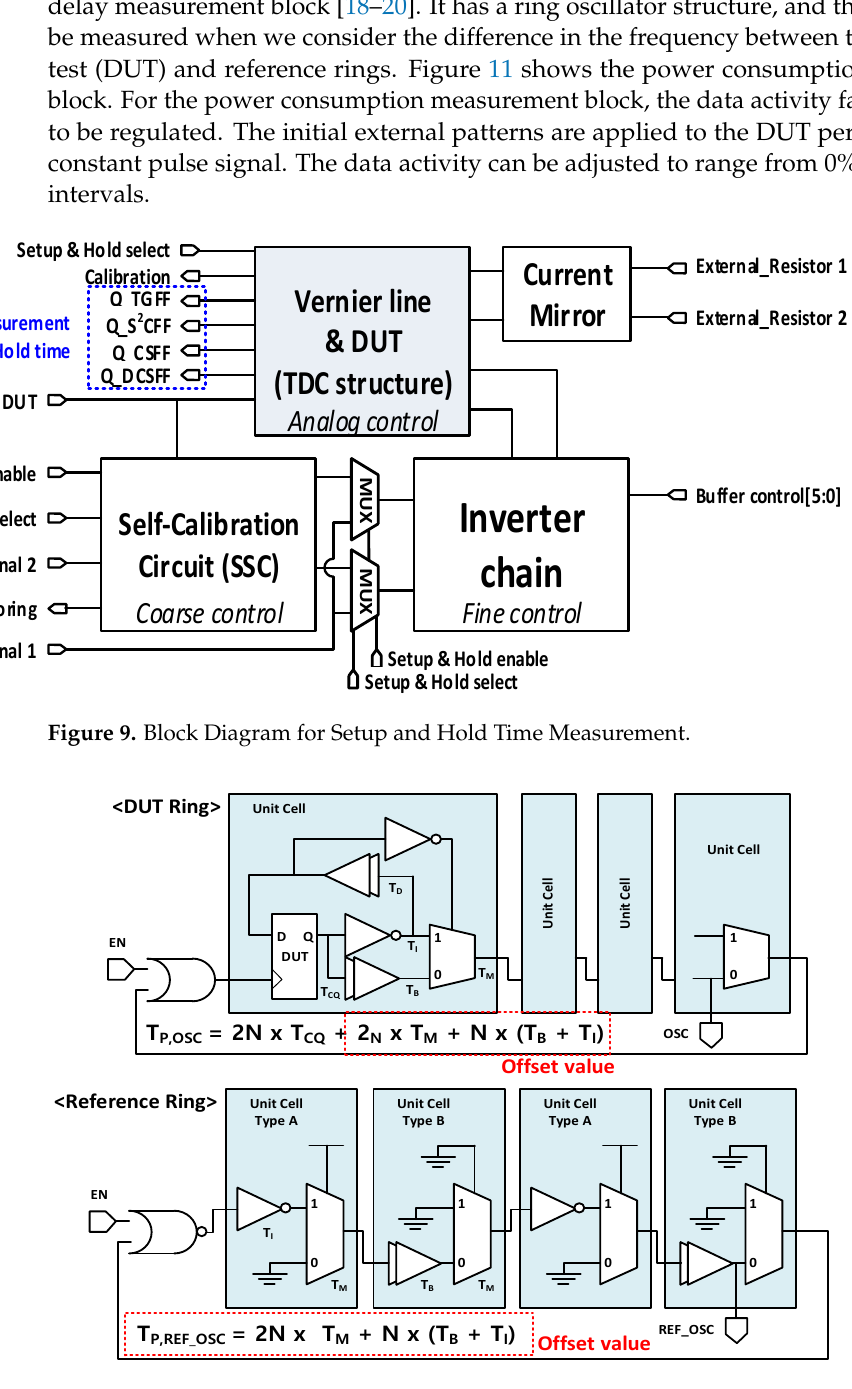
Figure 10. Block Diagram of Power Measurement.